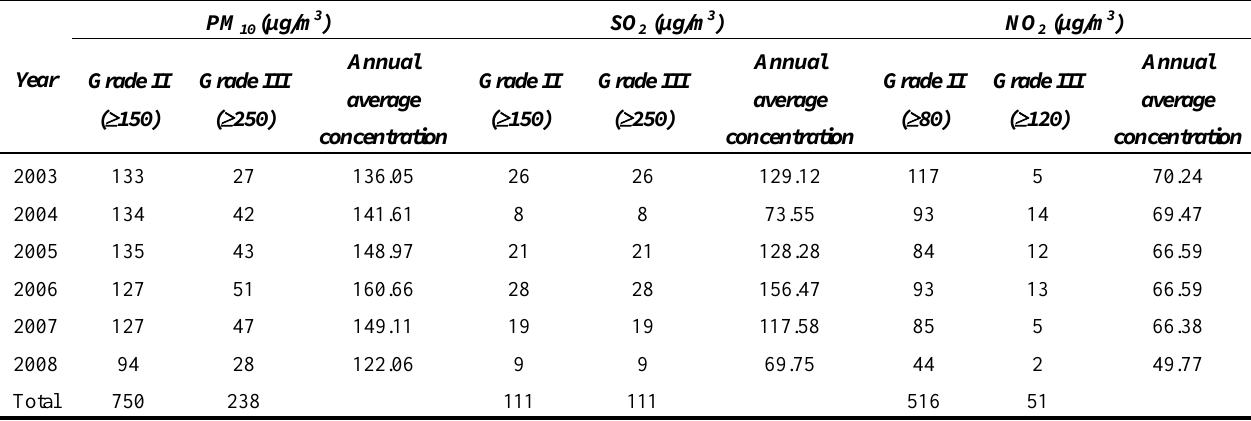
Table 2. Number of days/per annum with air pollutants exceeding the standard limits and annual average concentration of the